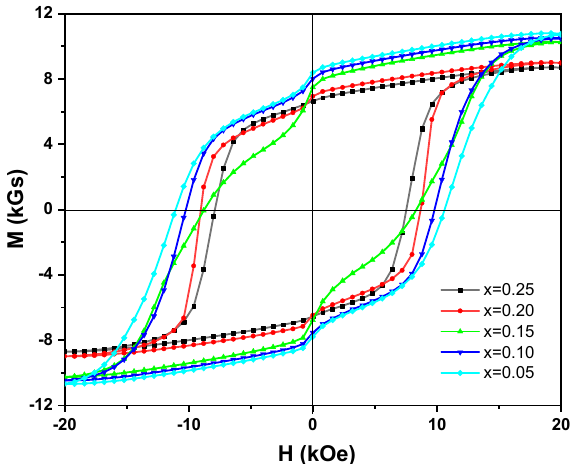
Figure 5. Hysteresis loops of (Nd 1-2x Ce x Y x ) 14.5 Fe 79.3 B 6.2 (x = 0.05, 0.10, 0.15, 0.20, 0.25) melt-spun ribbons at room temperature.